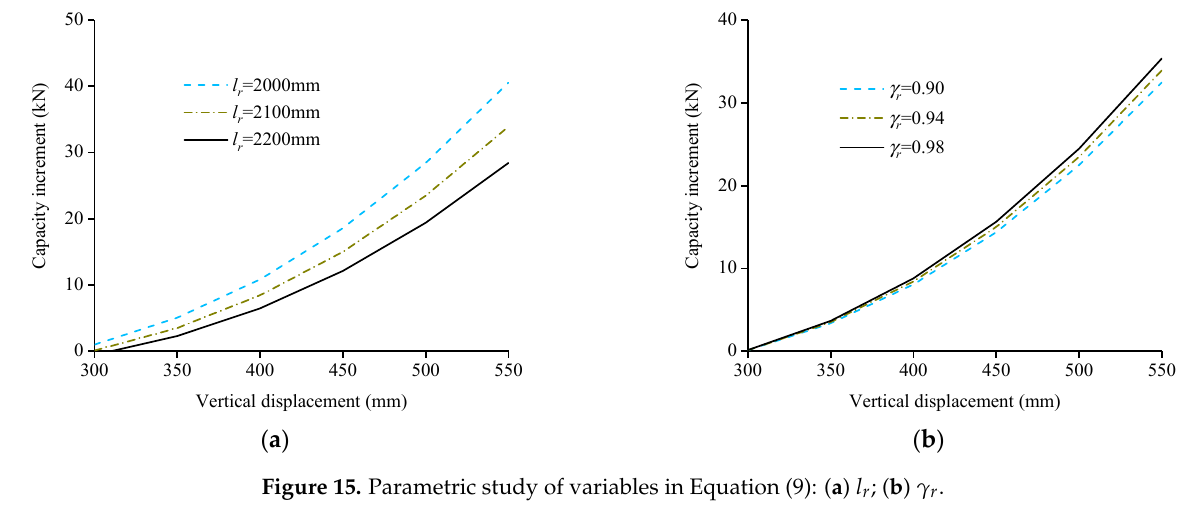
l ; ( b ) γ . Figure 15. Parametric study of variables in Equation (9): ( a ) l l ; ( b ) r r ; ( b ) γ r r r